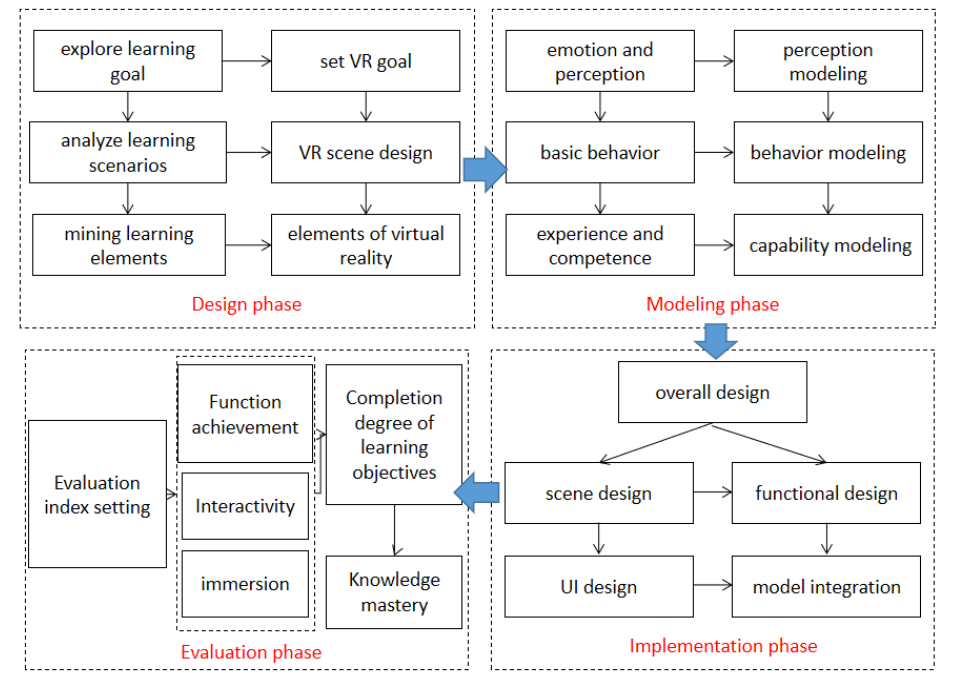
Figure 2. VR-enhanced cognitive learning framework.